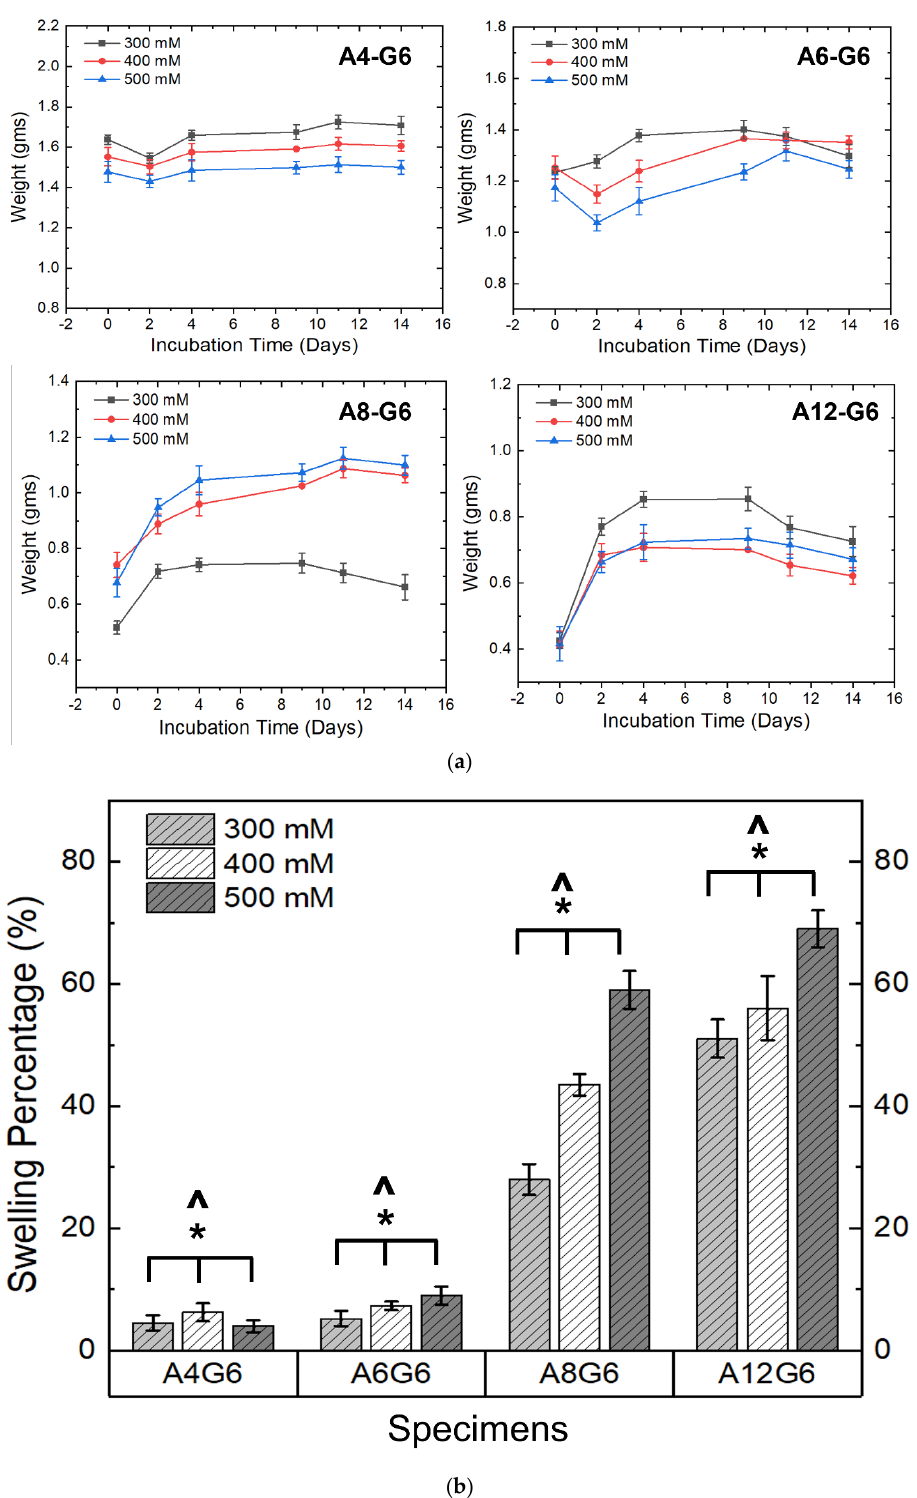
Figure 7. ( a ) Weight distribution of the alginate–gelatin scaffolds over the incubation period indi- cating the swelling nature of different printed scaffolds over time. ( b ) Swelling percentage of the printed scaffolds over 14 days. * indicates that at 0.05 level (two-way ANOVA), the variation in the crosslinking concentrations had a significant effect on the swelling percentage of the scaffolds. ˆ indicates that at the 0.05 level (two-way ANOVA), varying alginate concentrations had a significant effect on the swelling percentage of the